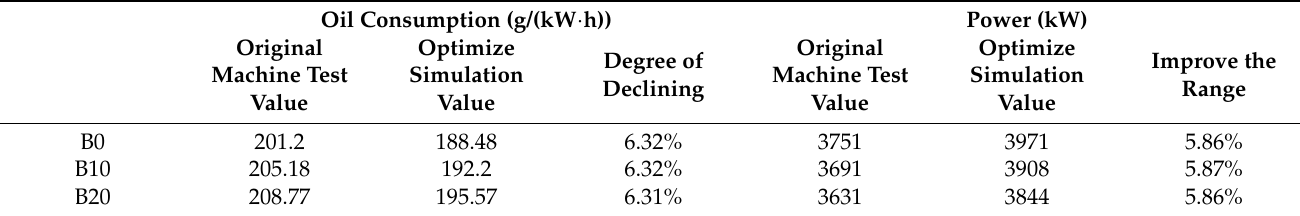
Table 5. The performance comparison before and after biodiesel